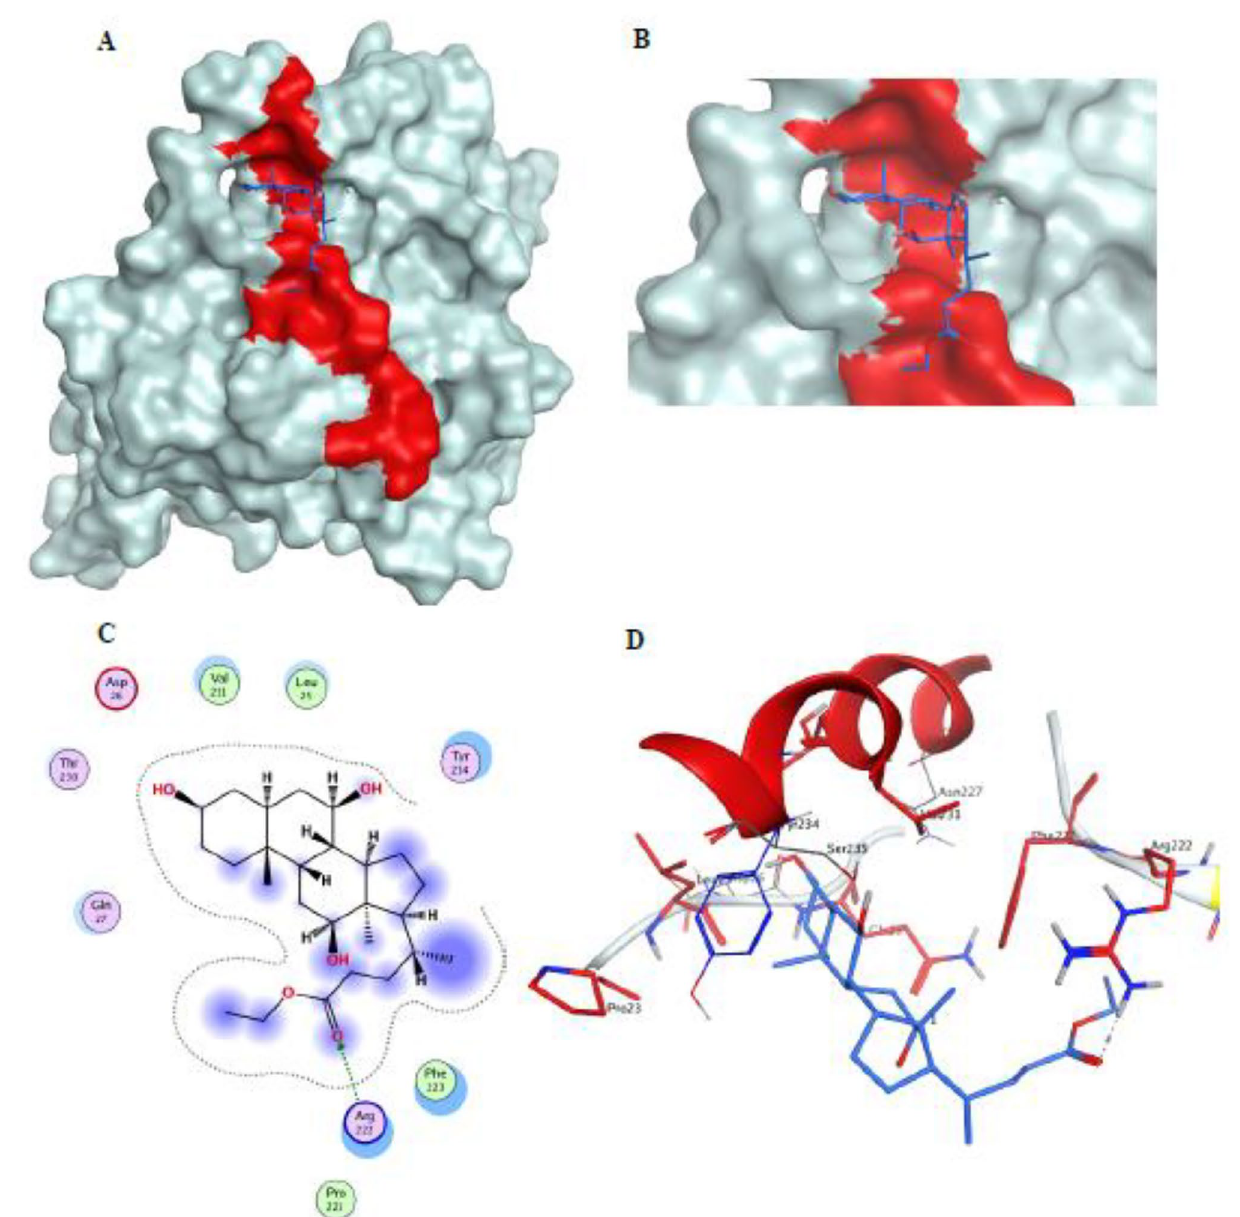
Figure 8. ( A ) Docking ethyl iso-allocholate (blue sticks) to the gD/nectin interaction site (red molecular surface) within the HSV gD (white molecular surface), ( B ) close-up view of ethyl iso-allocholate (blue sticks) contact sites on the gD motif involved in nectin binding, ( C ) 2D interactions, and ( D ) 3D binding mode of ethyl iso-allocholate (blue sticks) with key amino acids (red sticks) on gD (PDB ID: 3U82 38